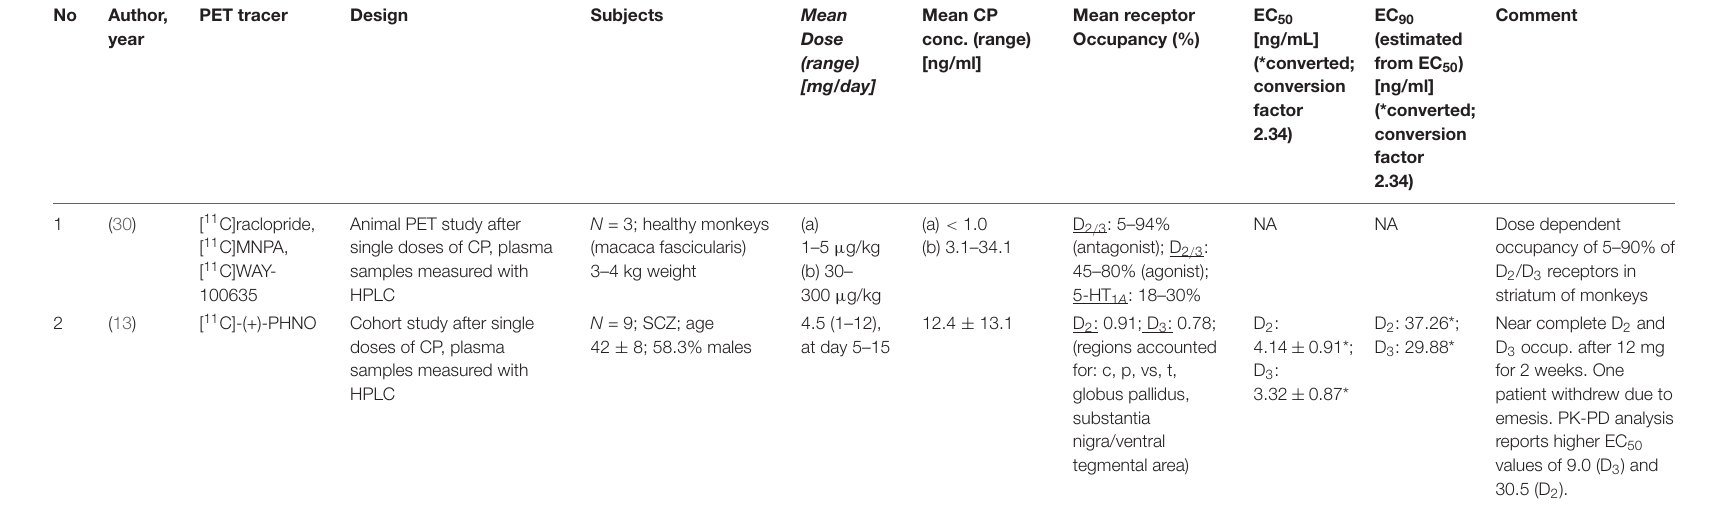
TABLE 3 | PET studies reporting D 2 receptor occupancy and cariprazine (CP) blood concentrations (*converted; conversion factor